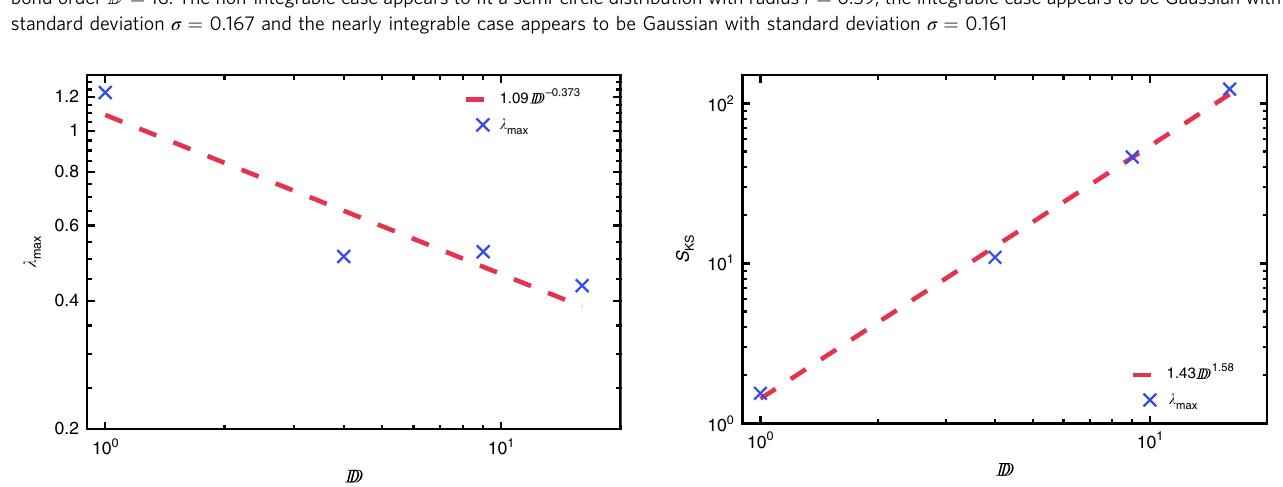
Fig. 9 Kolmogorov – Sinai entropy vs. thermo fi eld MPS bond order for non- integrable system. The Kolmogorov – Sinai entropy for the Ising model with J = 1, h x = 0.5, h z = 1.0 obtained for an MPS representation of the thermo fi eld double. The KS entropy appears to be divering, growing like S ¼ 1 : 4270 D 1 : KS